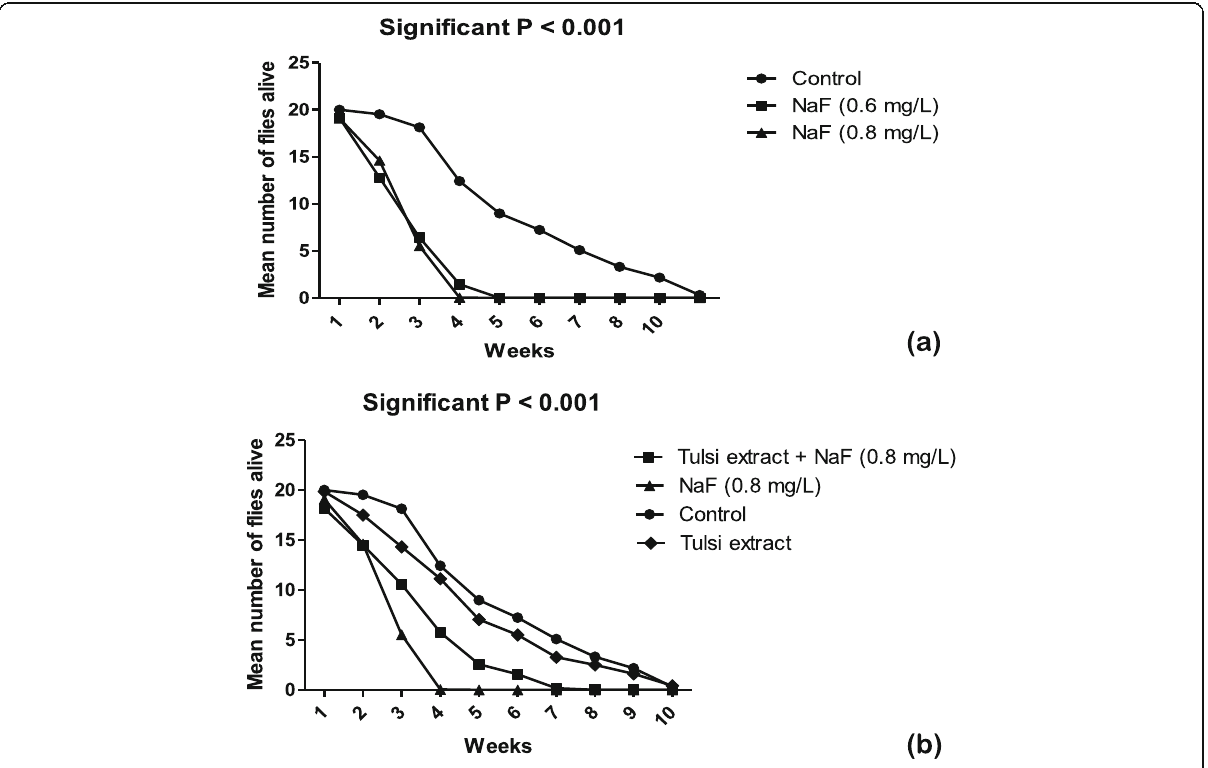
Fig. 1 Mean life span of Drosophila melanogaster in different